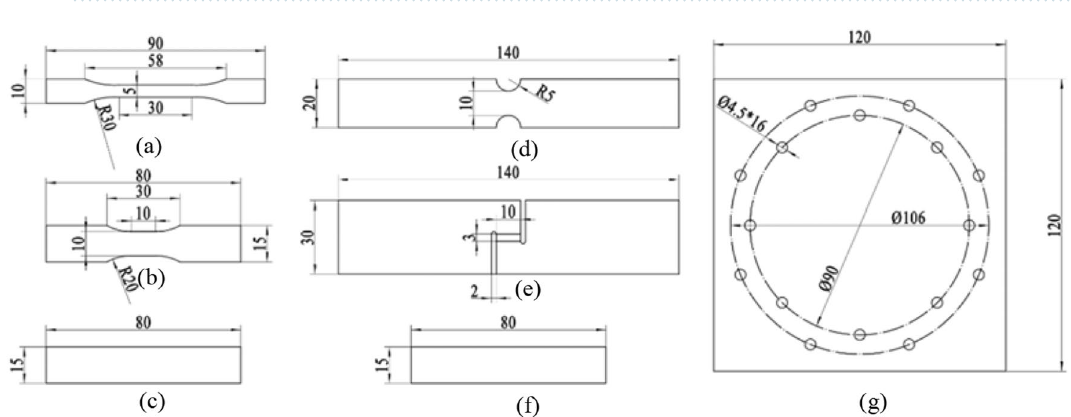
Figure 2. Schematic sketches of the specimens for: ( a ) static tension, ( b ) dynamic tension, ( c ) compression, ( d ) notched tensile, ( e ) grooved shear, ( f ) three-point bending and ( g ) puncture test (unit: